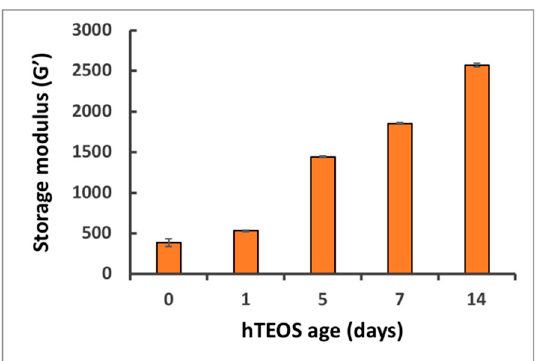
Figure 3. Effects of the age of hTEOS used for the TXG formulation and its stiffness (ANOVA analysis: p = 6.39 × 10 − 16 for alpha = 0.05, F = 3909.997 and F crit = 3.478).